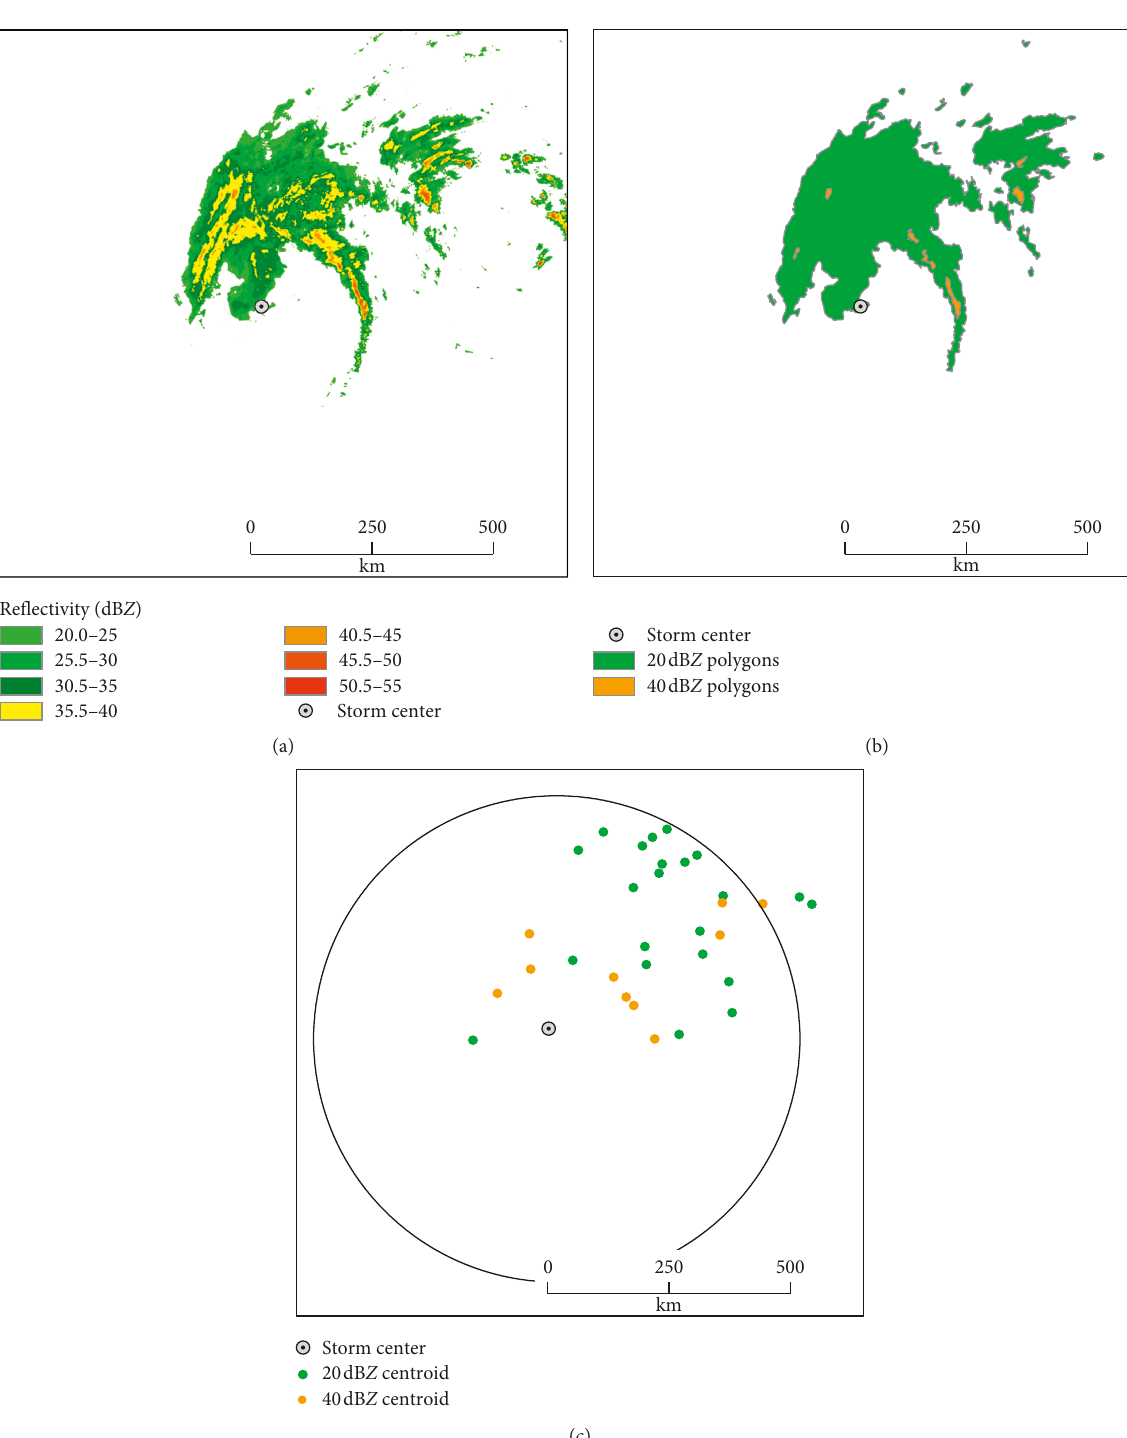
Figure 1: Hurricane Jeanne at 43hours after landfall showing (a) mosaicked radar reflectivity values at 3.5km altitude, (b) conversion of reflectivity values to polygons whose boundaries are used in the closure calculation, and (c) search radius of 500km where polygon centroids within this distance are used for the dispersion calculation. At this time, 20 dB Z closure is 0.81 or 292 ° while 40dB Z closure is 0.24 or 86 ° . Dispersion for 20 dB Z regions is 0.44 or 220km, while for 40dB Z regions, it is 0.50 or